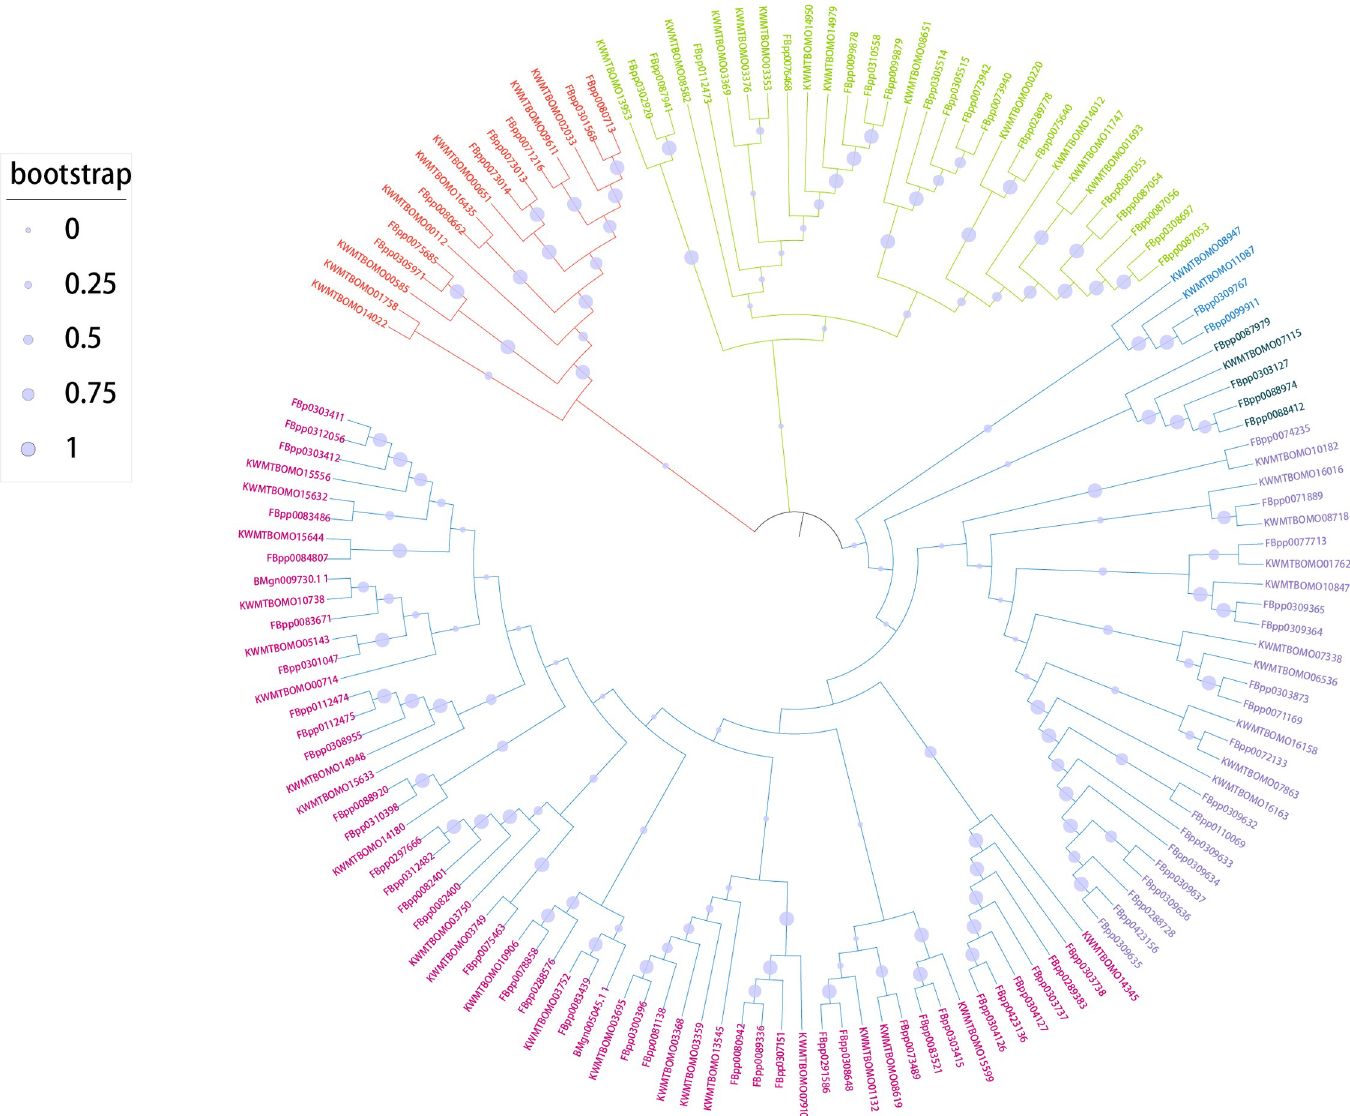
Fig 4. Phylogenetic analysis of the homeodomain TF family. The homeodomain TFs of B . mori and corresponding proteins of D . melanogaster were pooled, and alignments of complete TF amino acid sequences were generated using multiple protein sequence alignment (MUSCLE, http://www.drive5.com/muscle/). The phylogenetic tree was constructed via the neighbor-joining method with 1000 bootstrap replicates by using MEGA X. The percentage of replicate trees in which the associated taxa clustered together in the bootstrap test are shown next to the branches. The evolutionary distances were computed using the p-distance method.